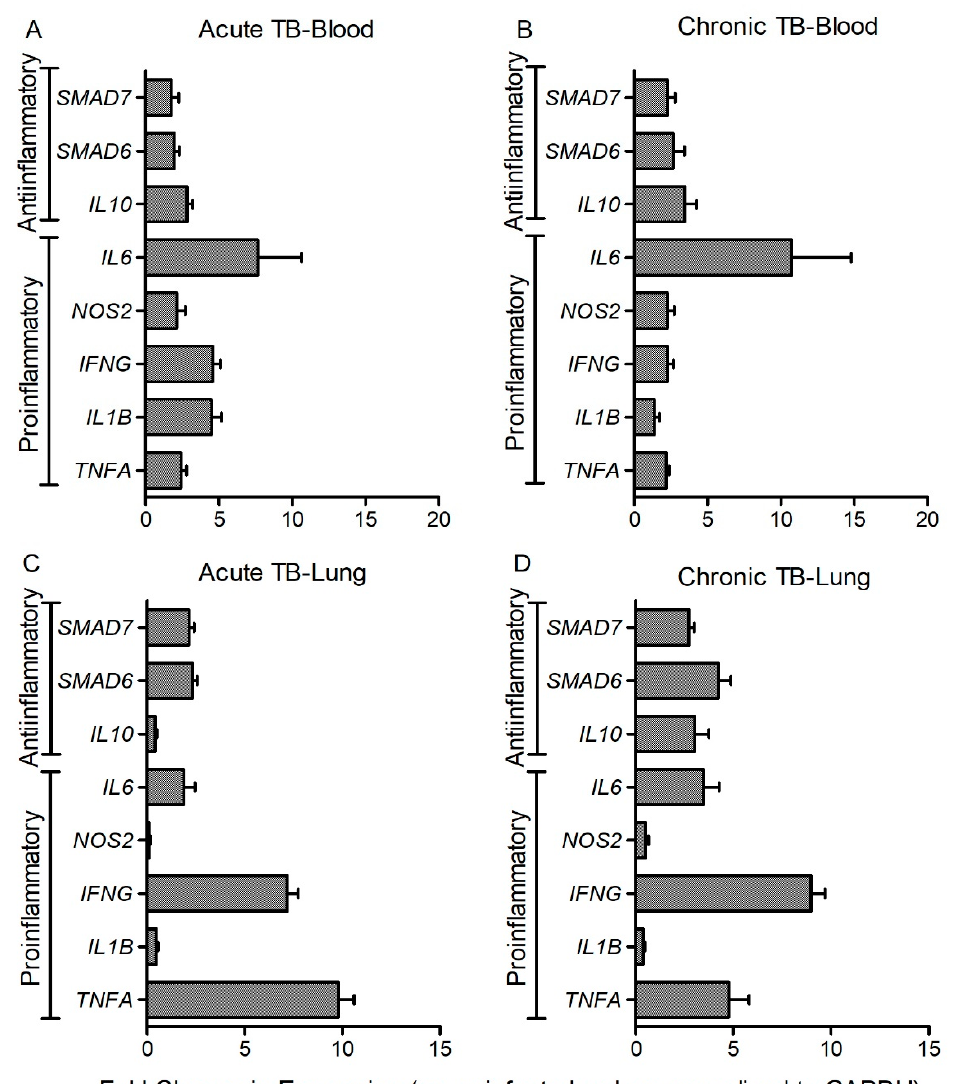
Figure 5. Expression of host pro- and anti-inflammatory response genes in Mtb-infected rabbits at 8 and 16 weeks post infection. Data shown are expression of target genes in the blood ( A , B ) or lung ( C , D ) during acute (8 weeks; A , C ) or chronic (16 weeks; B , D ) stages of infection. The gene expression levels in Mtb-infected animals was calibrated with the corresponding levels in uninfected rabbits. Host house-keeping gene ( GAPDH ) expression was used to normalize the level of target gene expression. Data was analyzed by one-way Anova with Tukey’s multiple comparison test. Values plotted are mean +/– sd with n = 4 per group per time point. All tested genes were statistically significant ( p < 0.05) in Figures 5A, B, C, D.